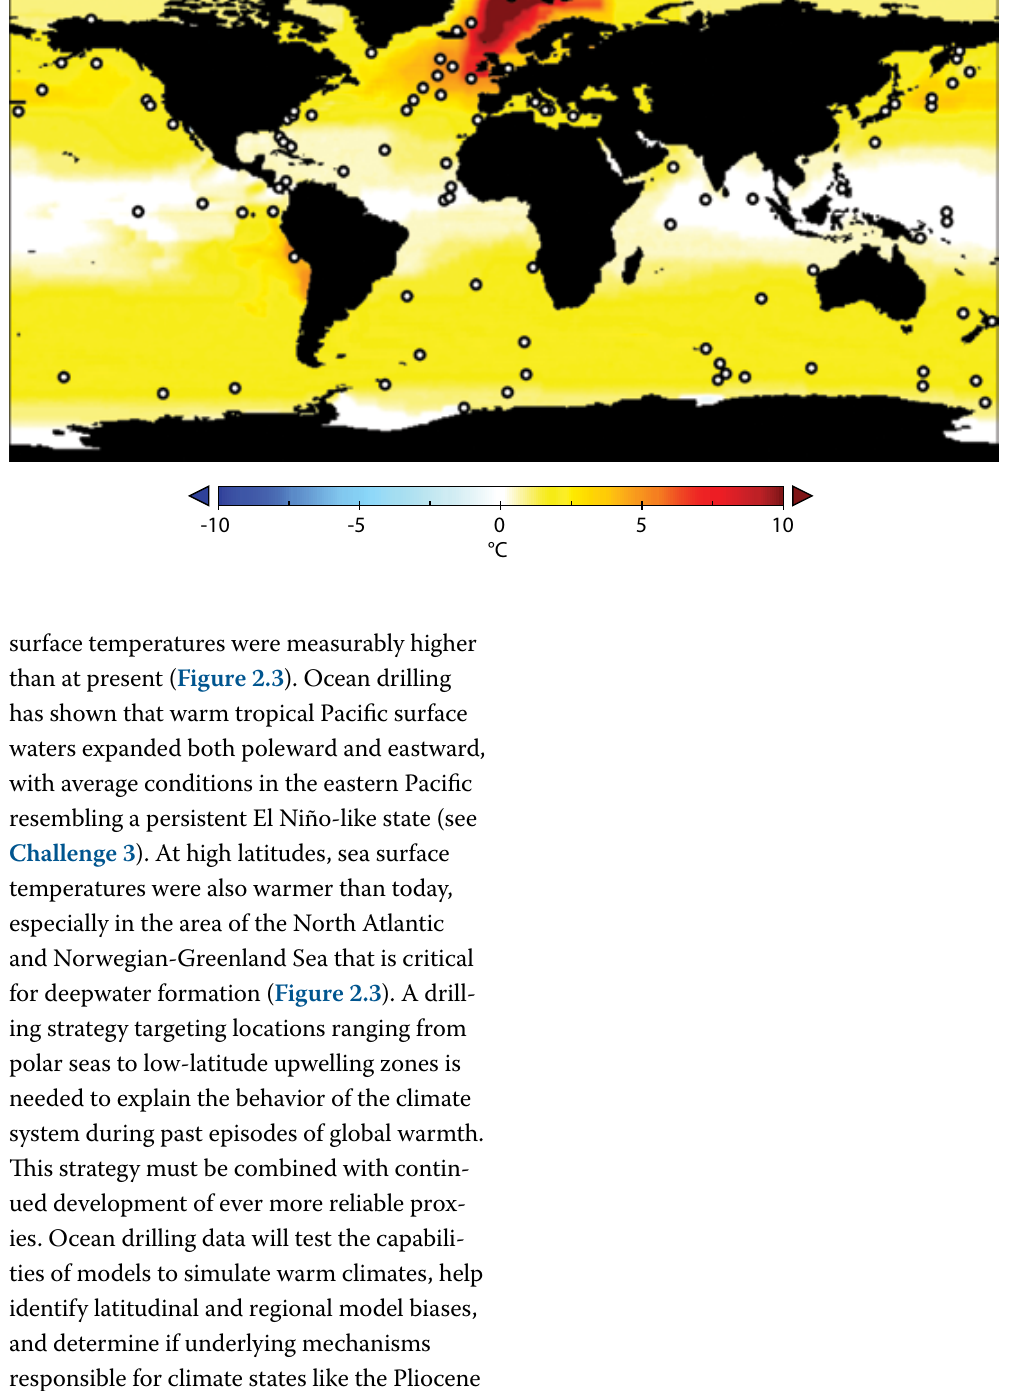
figure 2.3. difference between mean annual sea surface tem- perature averaged within peak interglacial periods from the time period 3.3–3.0 million years ago (dowsett et al., 2010) and modern sea surface temperatures (from reynolds and smith, 1995). Warm colors imply sea surface tempera- tures warmer than today, with the most dramatic warming observed in the northeast north atlantic. past sea surface temperatures are reconstructed using a variety of proxy methods from a global array of deep-sea cores (open